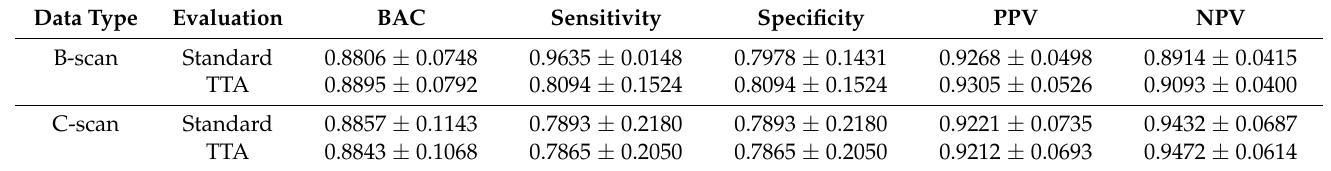
Table 2. Summary of results by the network for the different imaging modalities (B-scan vs. C-scan), applying different evaluation techniques (standard vs. test time augmentation (TTA)) and resampling imbalance strategy. Note that the numbers report “mean ± std”